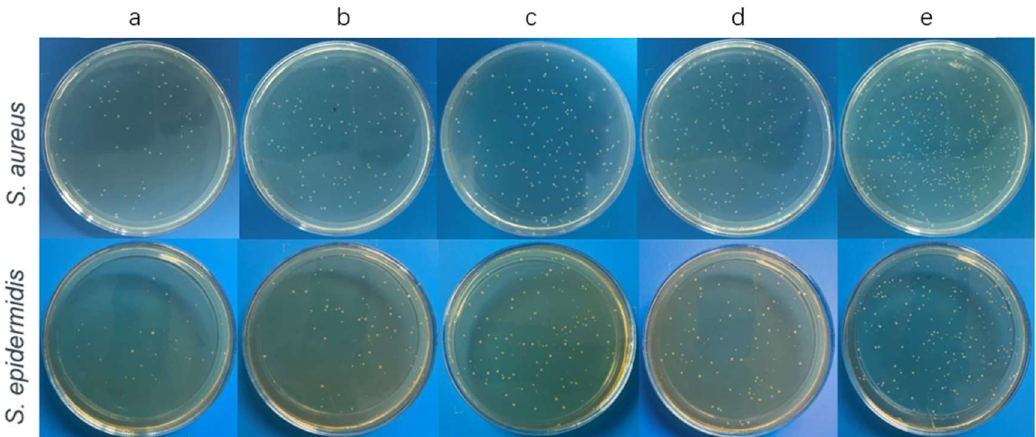
Figure 4. Typical images of re-cultivated S. aureus and S. epidermidis colonies from the samples after 6 h incubation. Notes : ( a ) groove pattern; ( b ) micro-hole pattern; ( c ) directional grain pattern; ( d ) stripe pattern ( e ) control group.